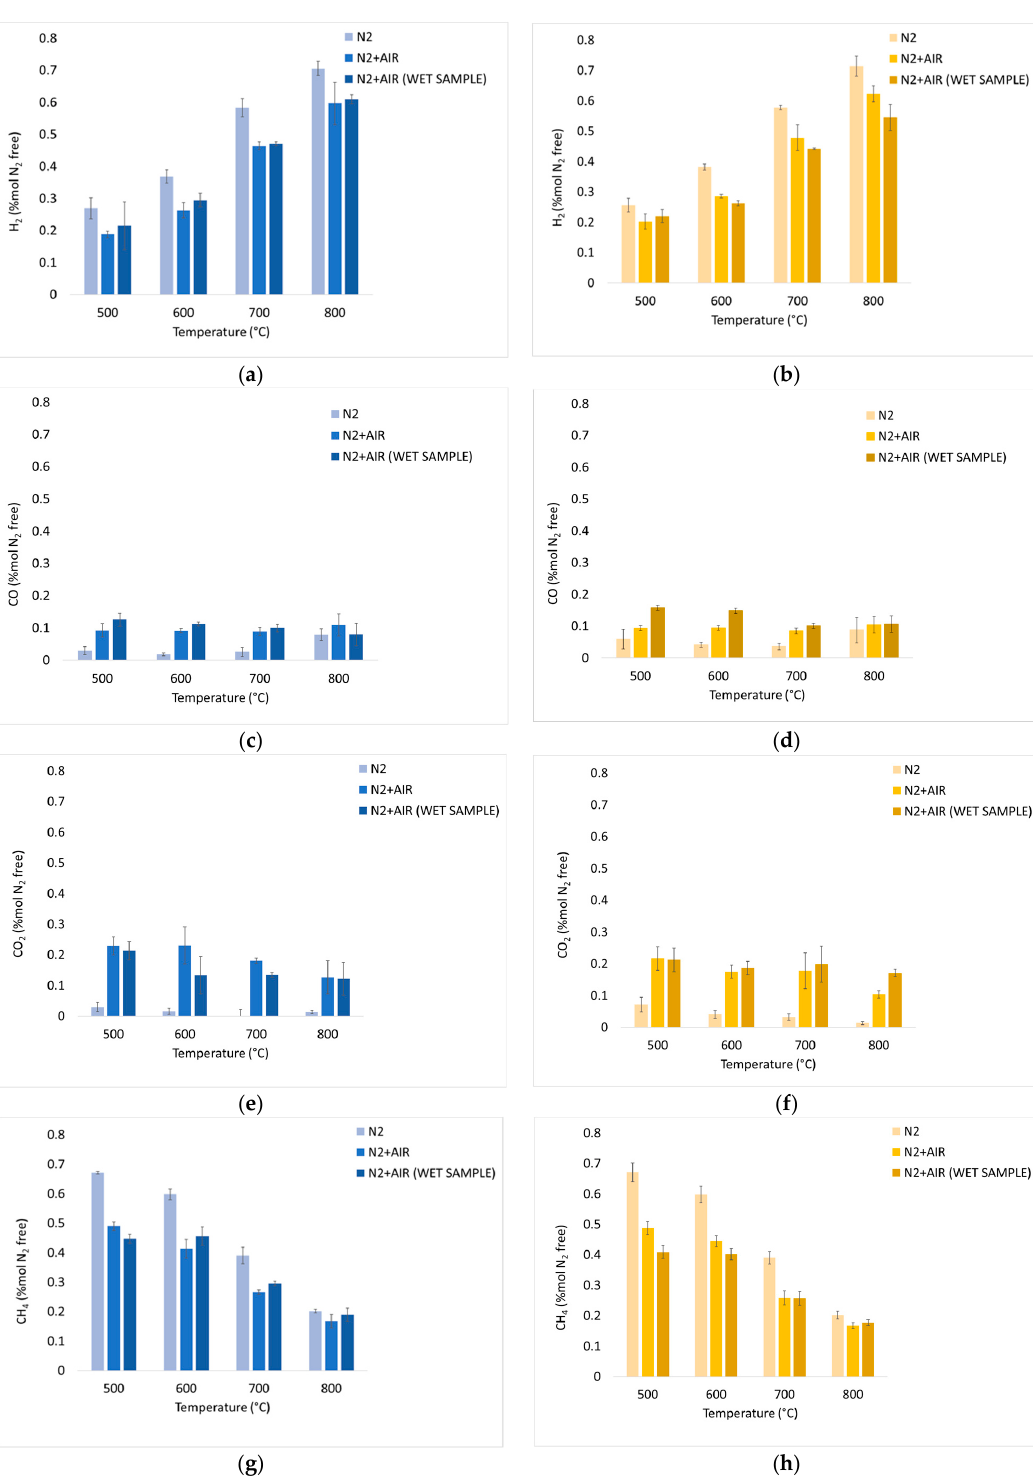
Figure 9. Experimental results of devolatilization tests in a nitrogen atmosphere, in a fluidized sand bed, as functions of temperature: integral average H 2 mol% dry, dilution-free Y av , i (Equation (7)) of chirurgical ( a ) and FFP2 ( b ) masks; CO mol% dry, dilution-free Y av , i (Equation (7)) of chirurgical ( c ) and FFP2 ( d ) masks; CO 2 mol% dry, dilution-free Y av , i (Equation (7)) of chirurgical ( e ) and FFP2 ( f ) masks; CH 4 mol% dry, dilution-free Y av , i (Equation (7)) of chirurgical ( g ) and FFP2 ( h ) masks. Figure 11 shows the aromatic hydrocarbon compounds detected and quantified in the liquid phase condensed downstream the devolatilization